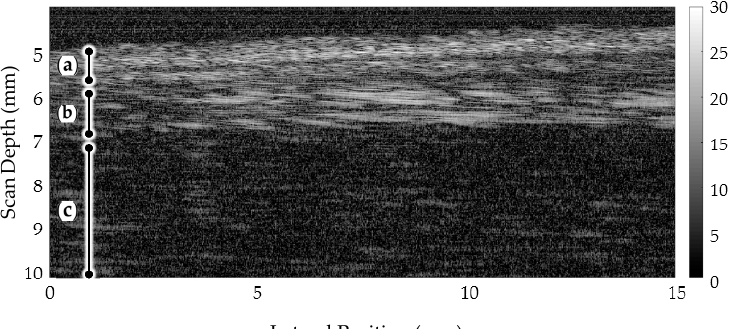
Figure 3. 48 MHz microultrasound scan of ex vivo porcine esophageal tissue. Tissues layers can be distinguished as ( a ) mucosa, ( b ) submucosa and ( c ) muscularis propria and serosa.